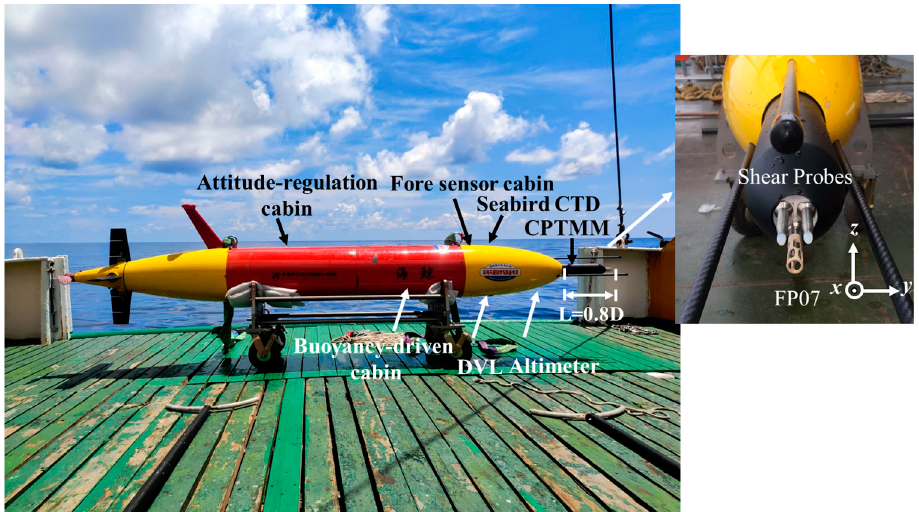
Figure 1. The structural components and oceanographic sensors of the long-range hybrid AUV. It is 3 m long, 0.35 m diameter, 200 kg mass and has a 1500 km endurance. Shown are the various micro and fine structure sensor systems. These include the Seabird GPCTD, the Nortek DVL, the dissolved oxygen, and the CPMTM for turbulence measurements. The CPMTM is in the middle of the fore sensor cabin and the shear probes are 0.8 D away from the nose.